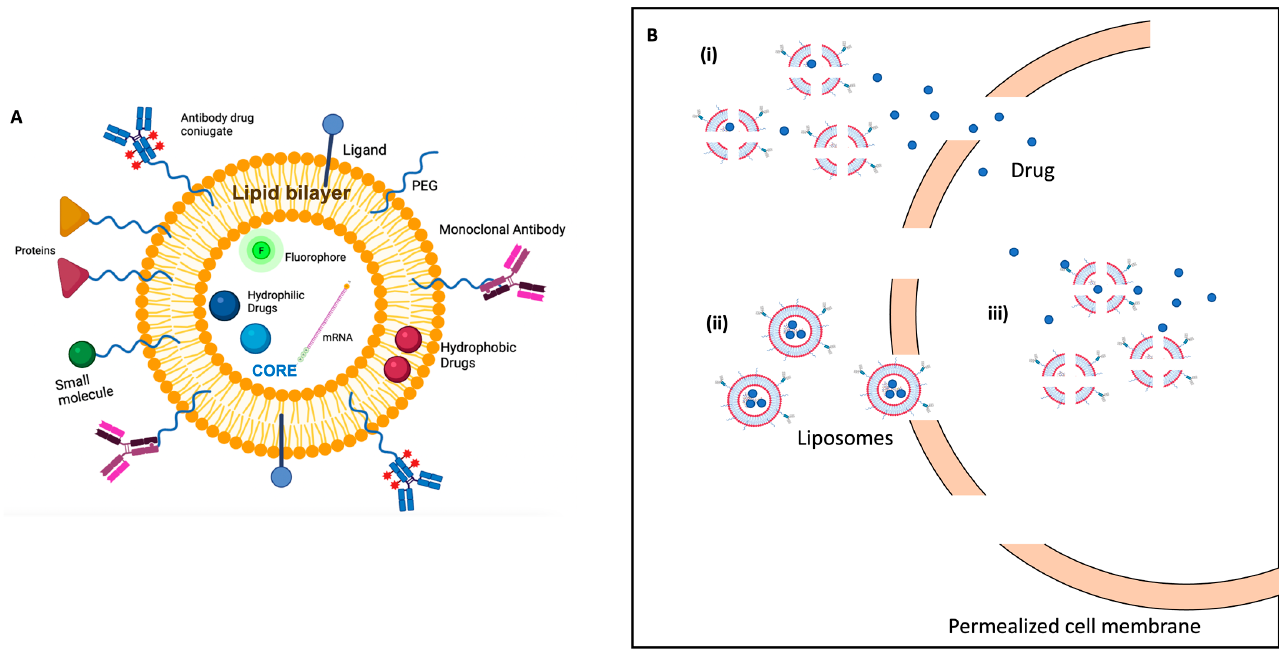
Figure 5. ( A ) graphic representation of lipid bilayer liposome carrying hydrophilic molecules in the core and hydrophobic molecules in the lipid portion with surface functionalization for selective, therapeutic, and/or diagnostic target action; ( B ) Electric field pulses effects on liposomes and cell membranes (i) liposomes membrane permealization and drug release nearby cell; (ii) liposome facilitated entry through permealized cell membrane; (iii) liposomes membrane permealization and intracellular drug release (created with BioRender—www.BioRender.com).